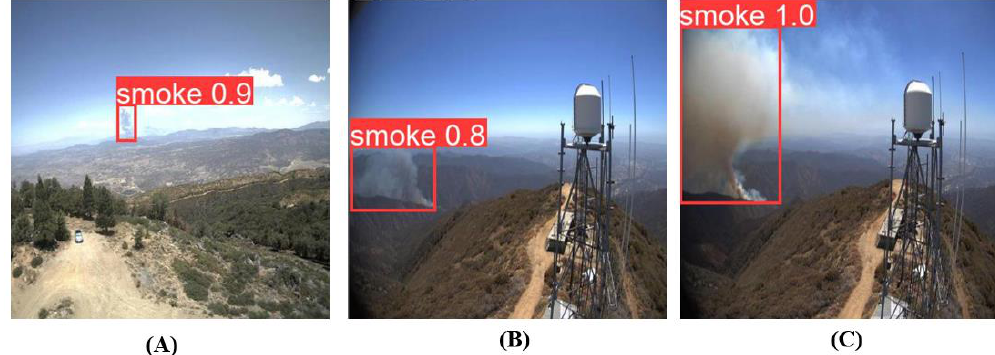
Figure 6. YOLOv5n detection areas results. ( A ) Far. ( B ) Medium. ( C ) Close.